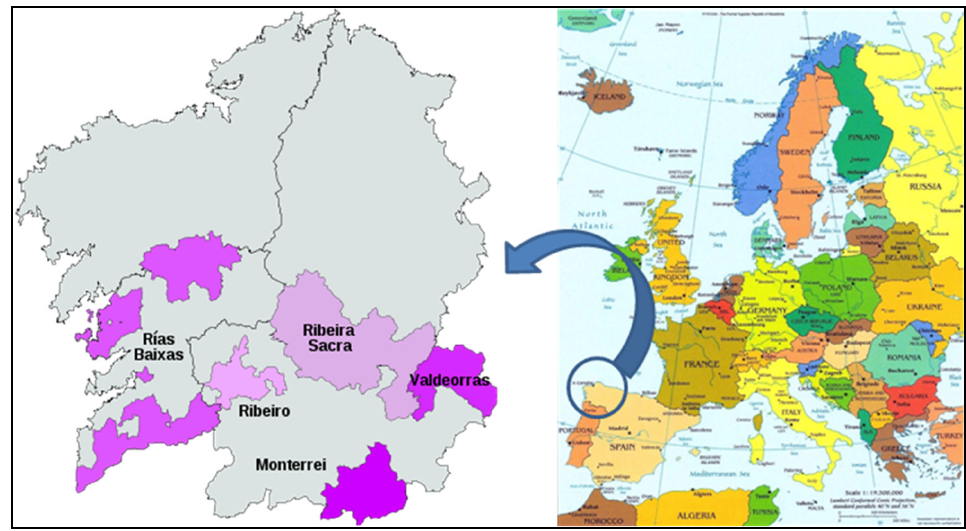
Figure 1. Denominations of origin from Galicia (NW Spain). Table 1. Galician wine denomination Origin (DO) data related to grape and wine production (year 2018).